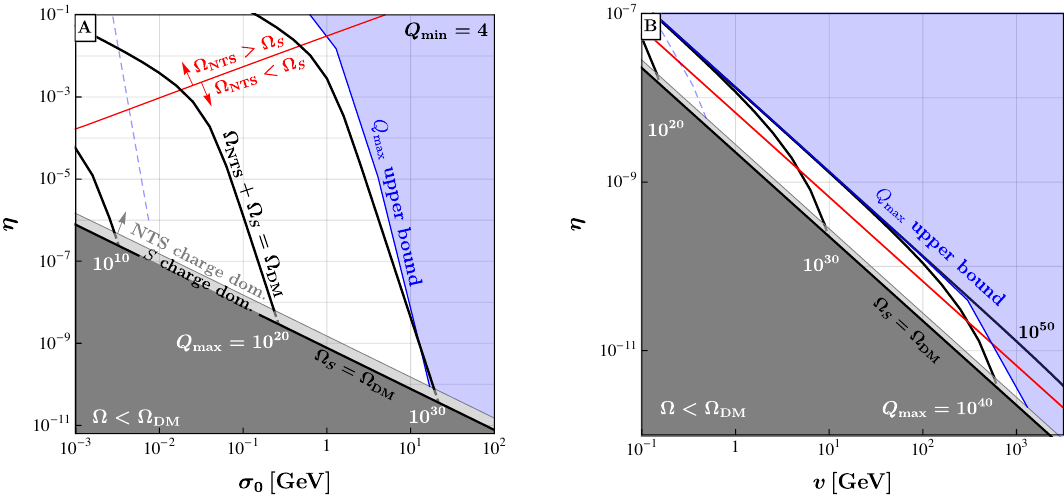
Figure 5 . The parameter space to have the summation of Q-balls and free S particles to explain the dark matter relic abundance Ω DM h 2 = 0 . 12 after solitosynthesis for Model A (left) and B (right). The gray line separates the Q-ball and S -particle charge-dominated regions, marking the boundary of efficient solitosynthesis. For the region above the red line, the Q-ball energy abundance is higher than the free-particle energy abundance. Different black solid curves correspond to different choices of Q max , and they all converge to the line of Ω S = Ω DM as η decreases (before they converge, the curves are plotted dashed in the light gray shaded region because the approximate formula in (3.13) breaks down here). The blue shaded region is excluded by the upper bound on Q max in (3.2) (left) or (3.3) (right) for Q min = 4 , where we have taken T = σ 0 or v . The thin blue dashed line is the same Q max upper bound but for Q min = 7 , where for Model B we chose λ φS = 6 . 2 instead of 10. Otherwise, model parameters are taken as the benchmarks in eq.